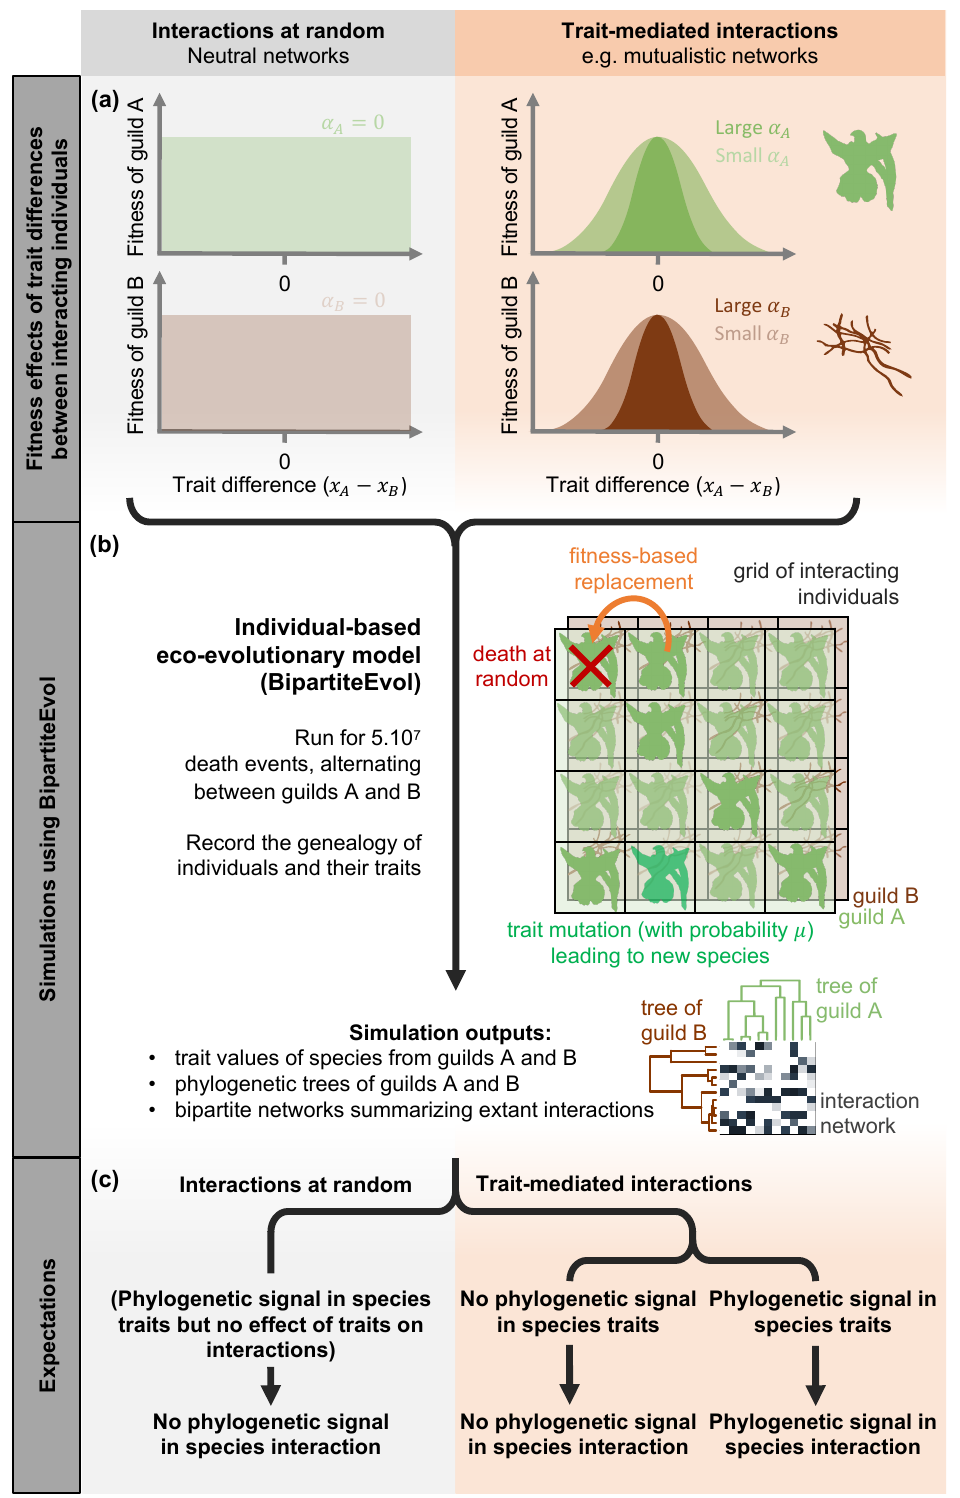
Figure 2: Simulation scheme used to generate interaction networks with or without phylogenetic signal in species interactions: (a) The fitness of a given individual is either affected by its trait value and that of the individual it interacts with (right; “mutualistic or antagonistic interactions”) or not (left;